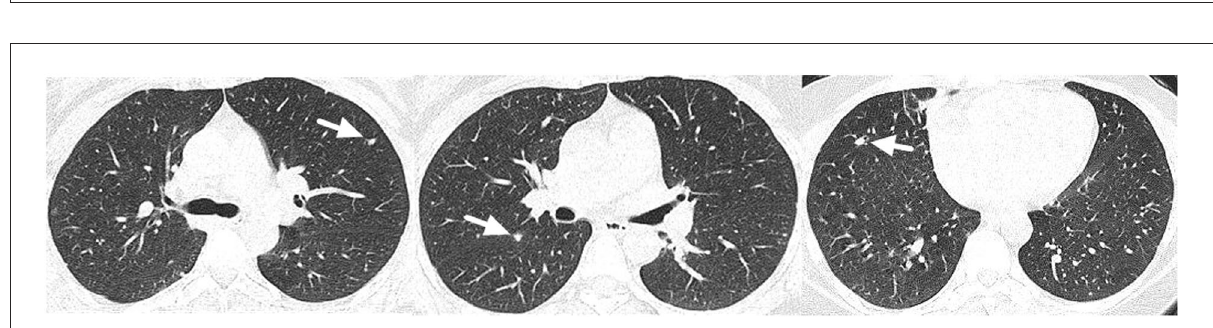
FIGURE2 Multiple small lesions were detected in the lung (marked with arrows).